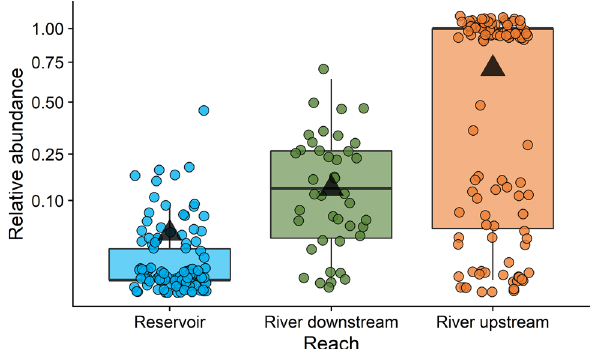
Figure 2. Relative abundance of native species in fish assemblages across the San Juan River–Lake Powell continuum from the reservoir, to the river downstream, to the river upstream. Triangles represent marginal means from a linear mixed effects model including reach as a fixed factor and a random effect of month nested within year, the bold lines are medians, box edges are the 25th and 75th quartiles, and whiskers extend from box edges to the smallest and largest value no further than 1.5 × the interquartile range. Points represent 0.1–3.2 km river reaches sampled or individual trammel nets in the reservoir. A small amount of jitter was added to points to reduce overlap. The y-axis has been scaled with a square root transformation to better show small proportions.